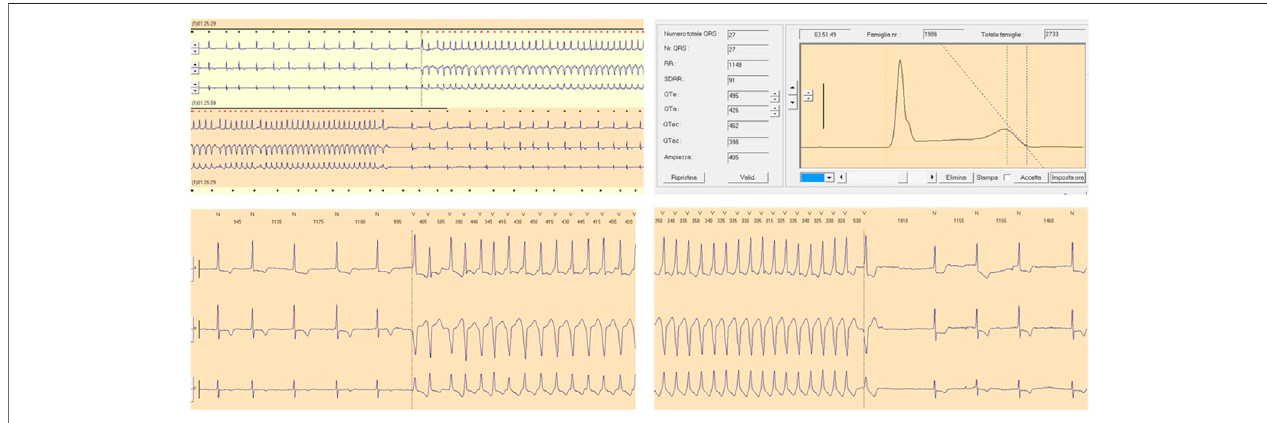
FIGURE 2 | QT prolongation and ventricular tachycardia following Paroxetine therapy. Moderate QT prolongation (corrected QT, QTc 462 ms) and ventricular tachycardia following Paroxetine therapy (dosage 20 mg per day) recorded during Holter monitoring in a female patient (age 70 years) with a history of depression.